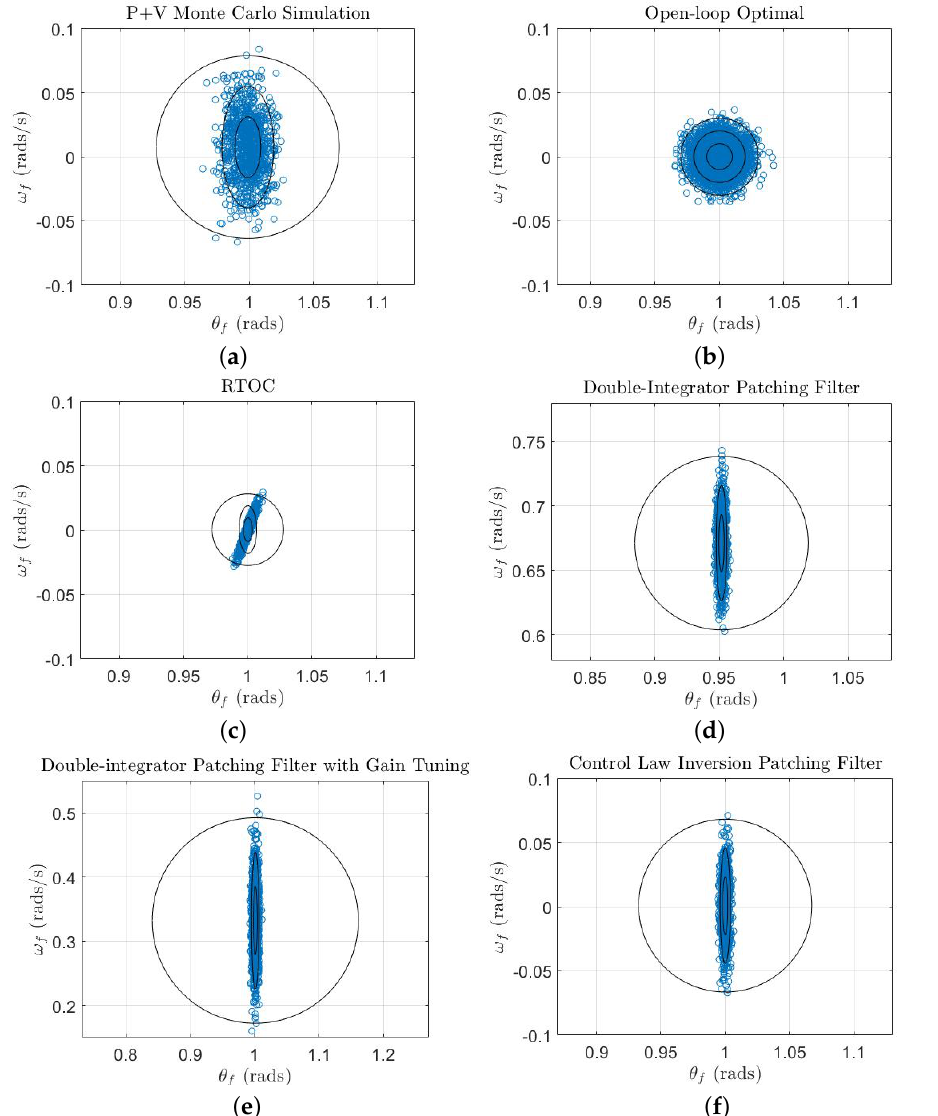
Figure 2. Monte Carlo simulations of six different controller schemes, n = 1000. Gaussian noise in state and rate sensors with zero mean and σ = 0.01 and uniform uncertainty in I = 1 ± 0.1. All simulations are run with ode4 Runge-Kutta integration with a step size of h = 0.01 s. ( a ) P+V control, ( b ) open-loop optimal feedforward control, ( c ) real-time optimal control, ( d ) double-integrator patching filter with P+V control. K P = 119.95 and K V = 15.33, ( e ) double-integrator patching filter with gain-tuning of P+V control. K P = 280 and K V = 15.33, ( f ) control law inversion patching filter with P+V control. K P = 119.95 and K V =